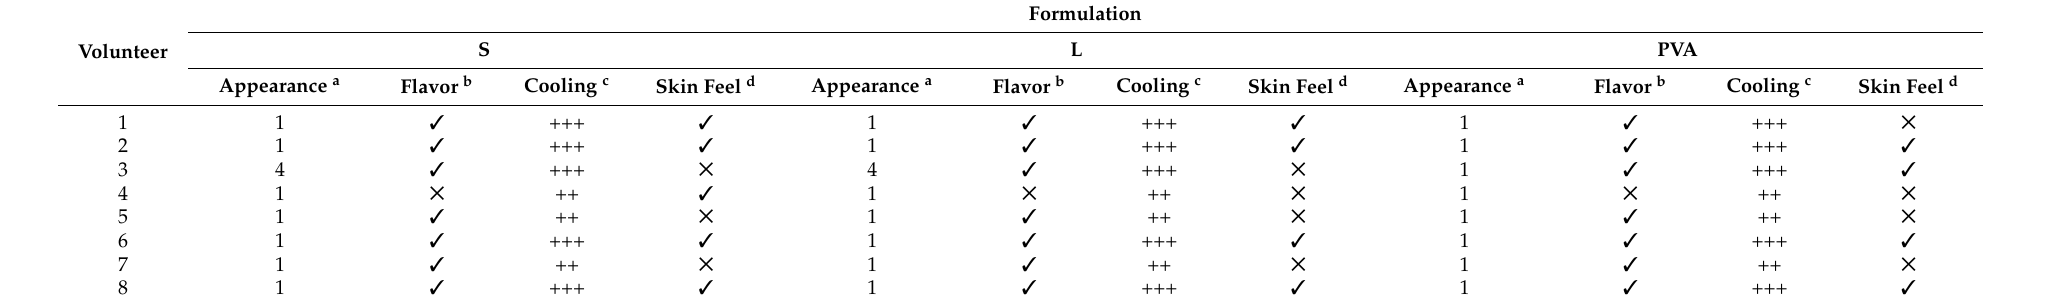
Table 5. In vivo evaluation of